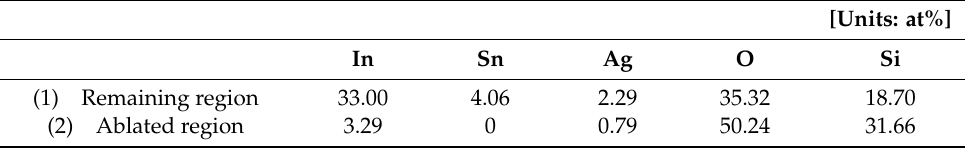
[units: [Units: at%] at%]